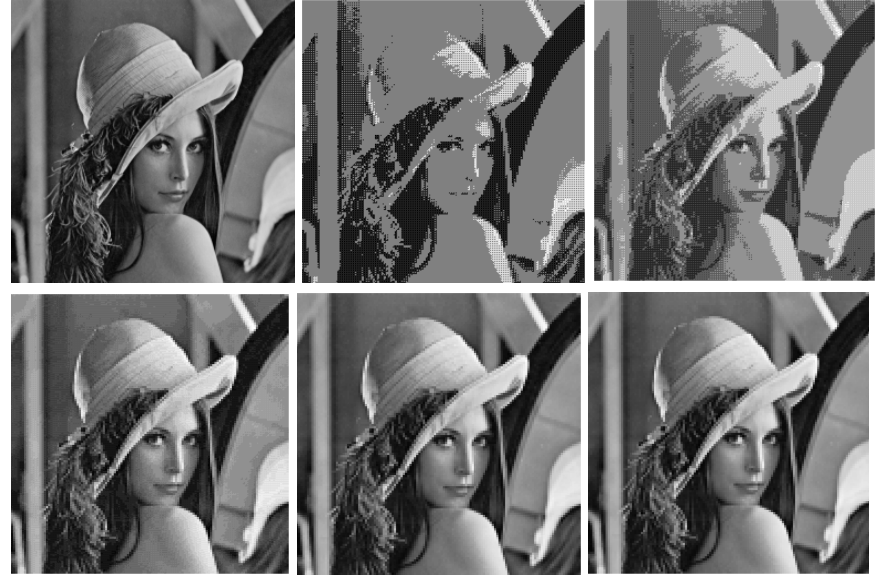
Figure 2: Top left corner: orinal image; left to right: reconstructed Lena image using 2 × 2 blocks at quality indices 5 , 10 , 50 , 90 , 95 .